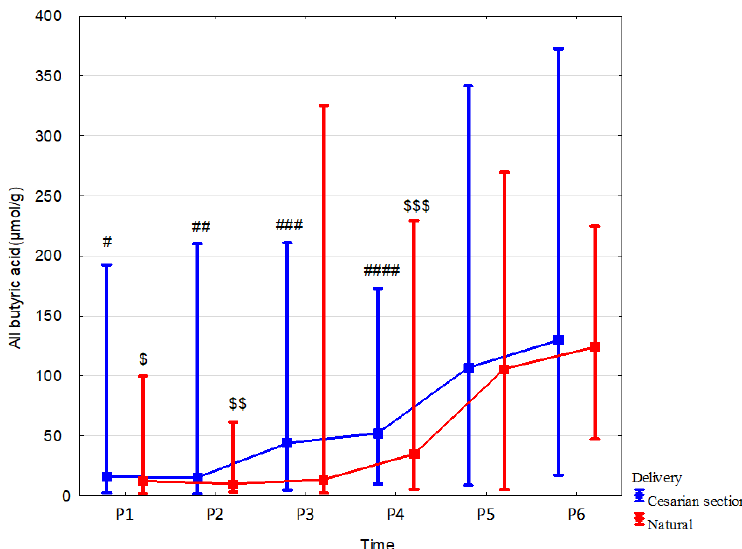
Figure 4. All butyric acid concentrations (median) in children over time according to delivery type: Cesarean section (blue line) or vaginal birth (red line). Legend: Error bars represent range. Wilcoxon paired tests regarding time, # (Cesarean section), $ (Vaginal delivery): #, $: p < 0.05 P1 vs. P5 and P6; ##, $$: p < 0.05 P2 vs. P4,P5 and P6; ### p < 0.05 P3 vs. P5 and P6; ####, $$$: p < 0.05 P4 vs. P5 and P6.